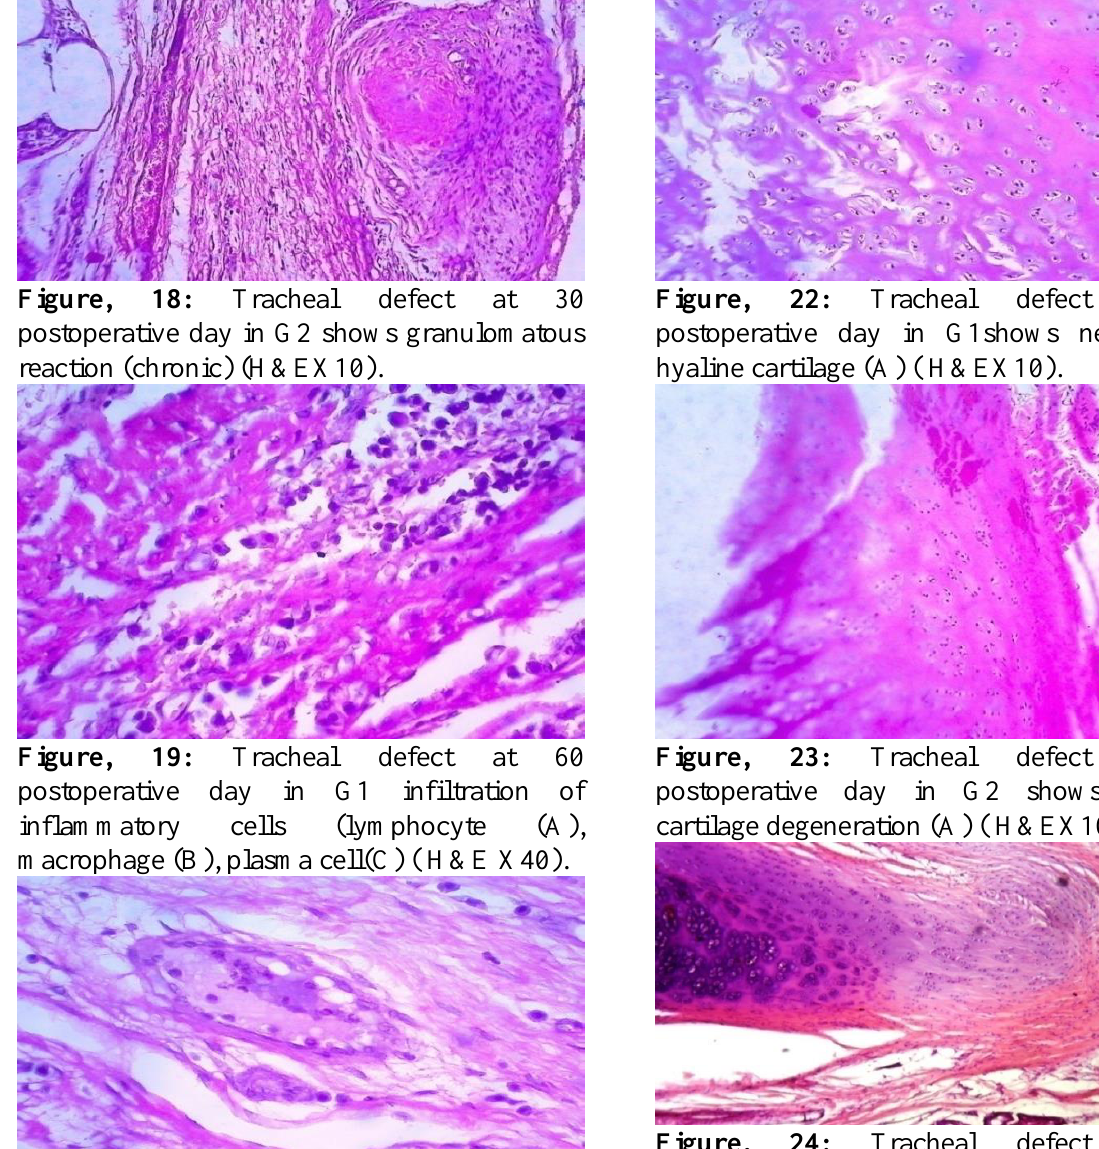
Figure, 20 : Tracheal defect at 60 postoperative day in G1 giant cells (A) (H&E X40).